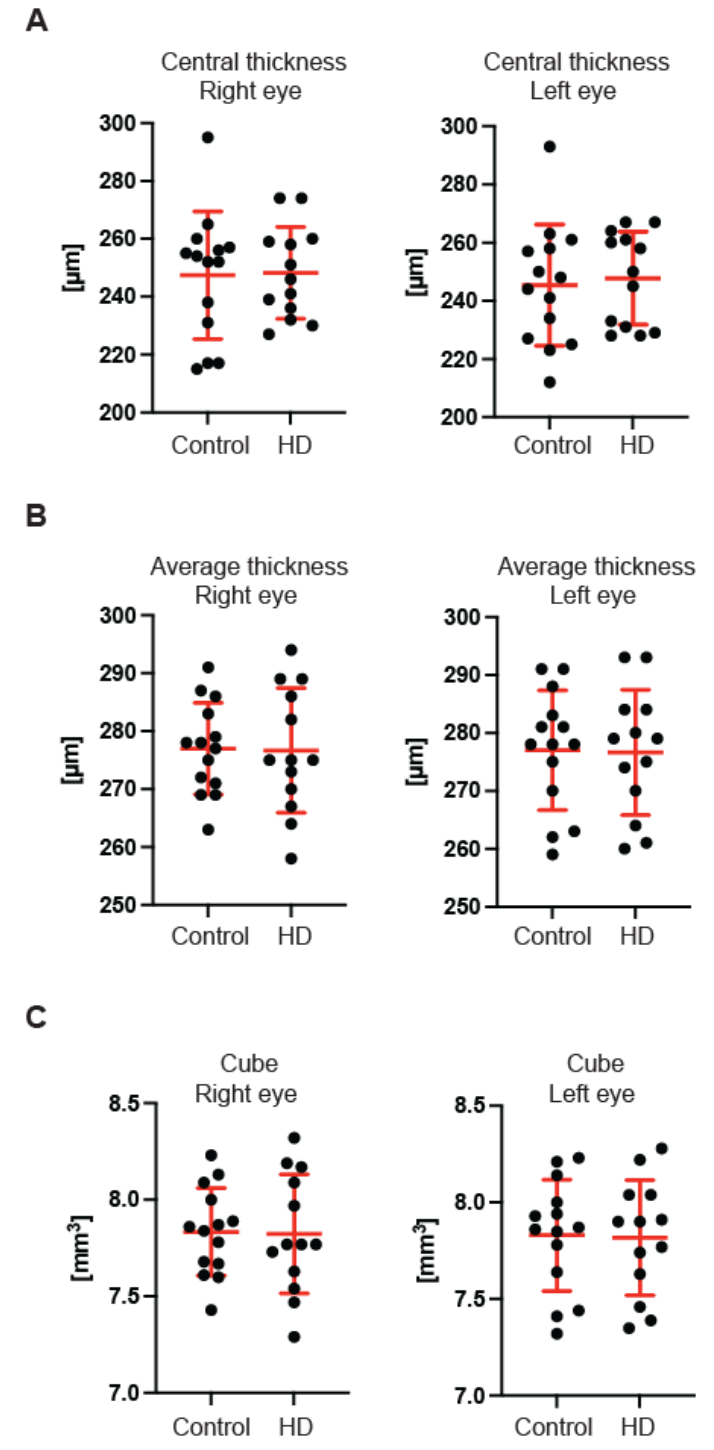
Figure 4. The retina thickness is unchanged in pre-symptomatic HD carriers using OCT. The cen- tral ( A ), the average ( B ) and the cube ( C ) volume of the retina from the inner limiting membrane (ILM) to the retinal pigment epithelium (RPE) were unchanged in the HD patients in comparison with the healthy controls. Error bars are ± SD ( n > 13). One-way ANOVA with Bonferroni post hoc test.